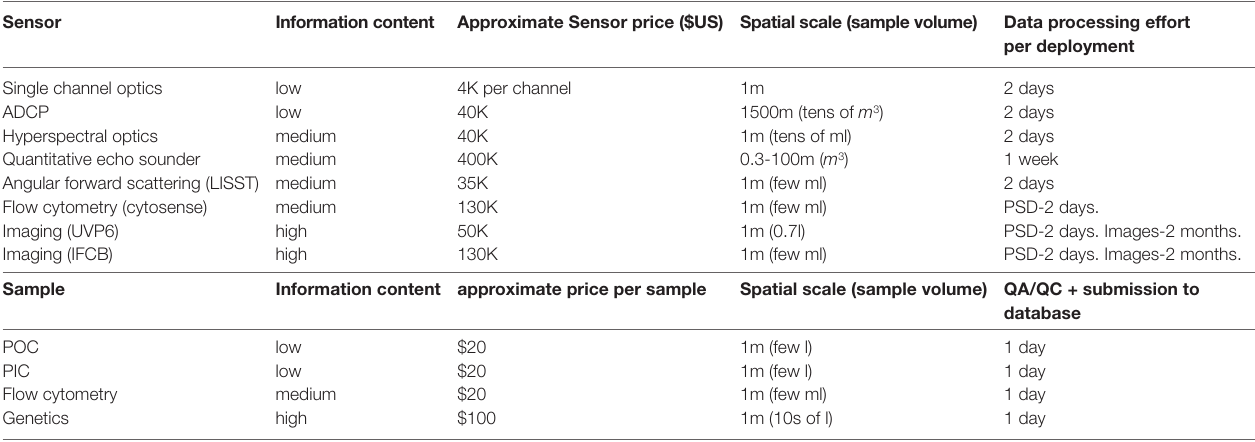
TABLE 1 | Information content generated under OceanSITES sampling, price (approximate, not including accessories), sampling mode (and hence density of sampling), spatial scale (vertical or horizontal depending on sampling mode) and approximate volume inquired per sample.